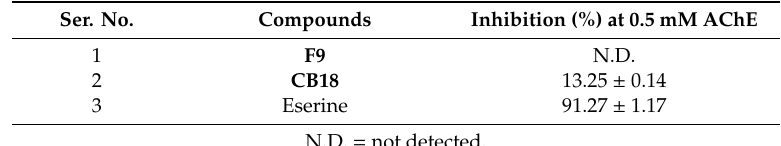
Table 4. AChE inhibition activities of isolates ( F9 & CB18 ) at 0.5 mM with Eserine as standard. The values represent average percentage inhibition ± standard error (S.E.) of three repeated experiments. Ser.